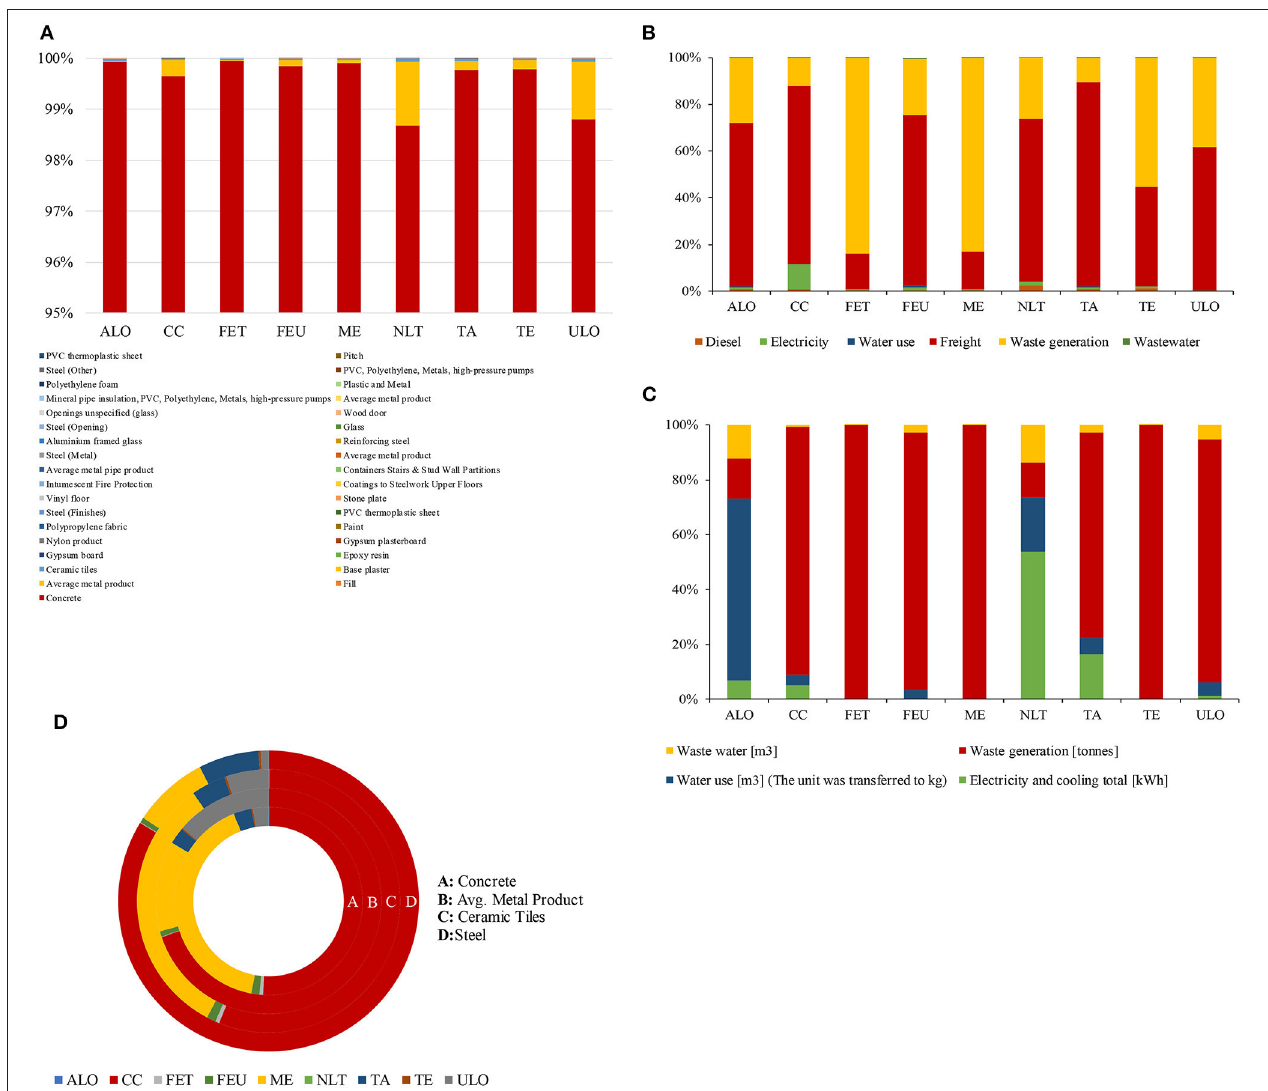
FIGURE 4 | (A) Material contribution in the resource production phase. (B) Contribution of activities in the construction phase. (C) Contribution of activities in the operations phase. (D) Contribution of materials across each impact category per phase.